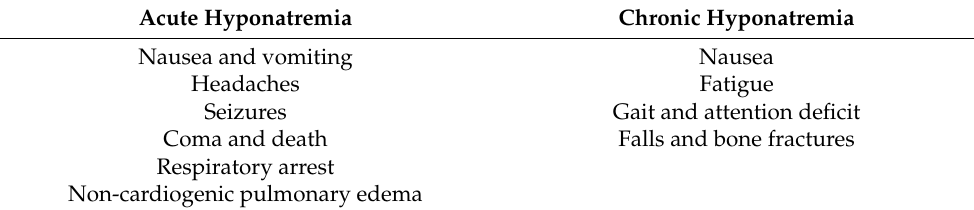
Table 1. Manifestations of hyponatremic